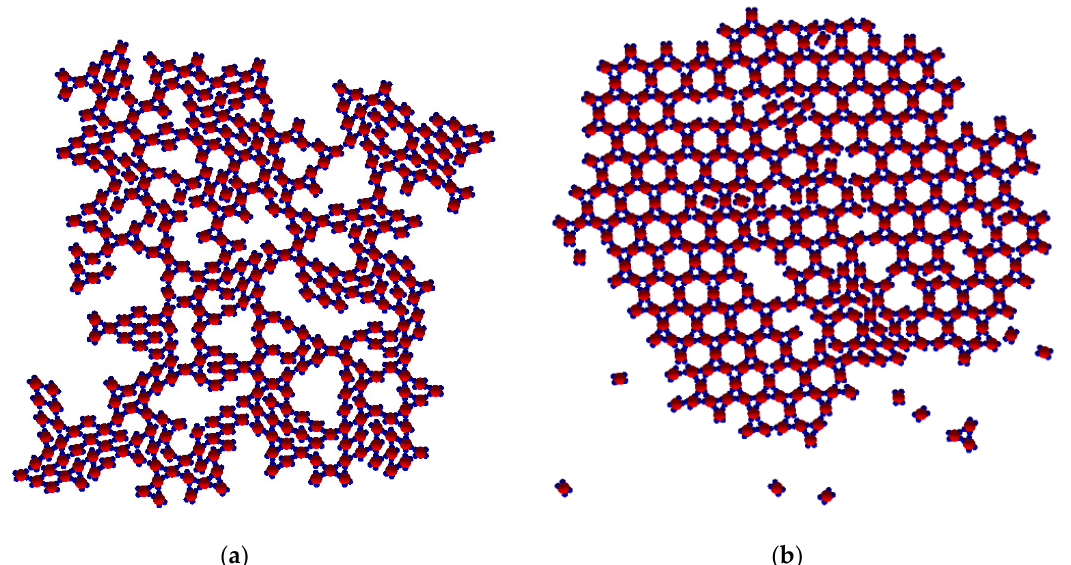
Figure 10. Patches with equal strength, SN type only, at T* = 0.10: ( a ) randomly interconnected small Rh phase crystalline clusters and a small number of TriHex rings; ( b ) polymorph transition at T* = 0.15: the final structure contains many more defects in comparison with the final structure at T* = 0.10 and two types (SN and WW) of interacting